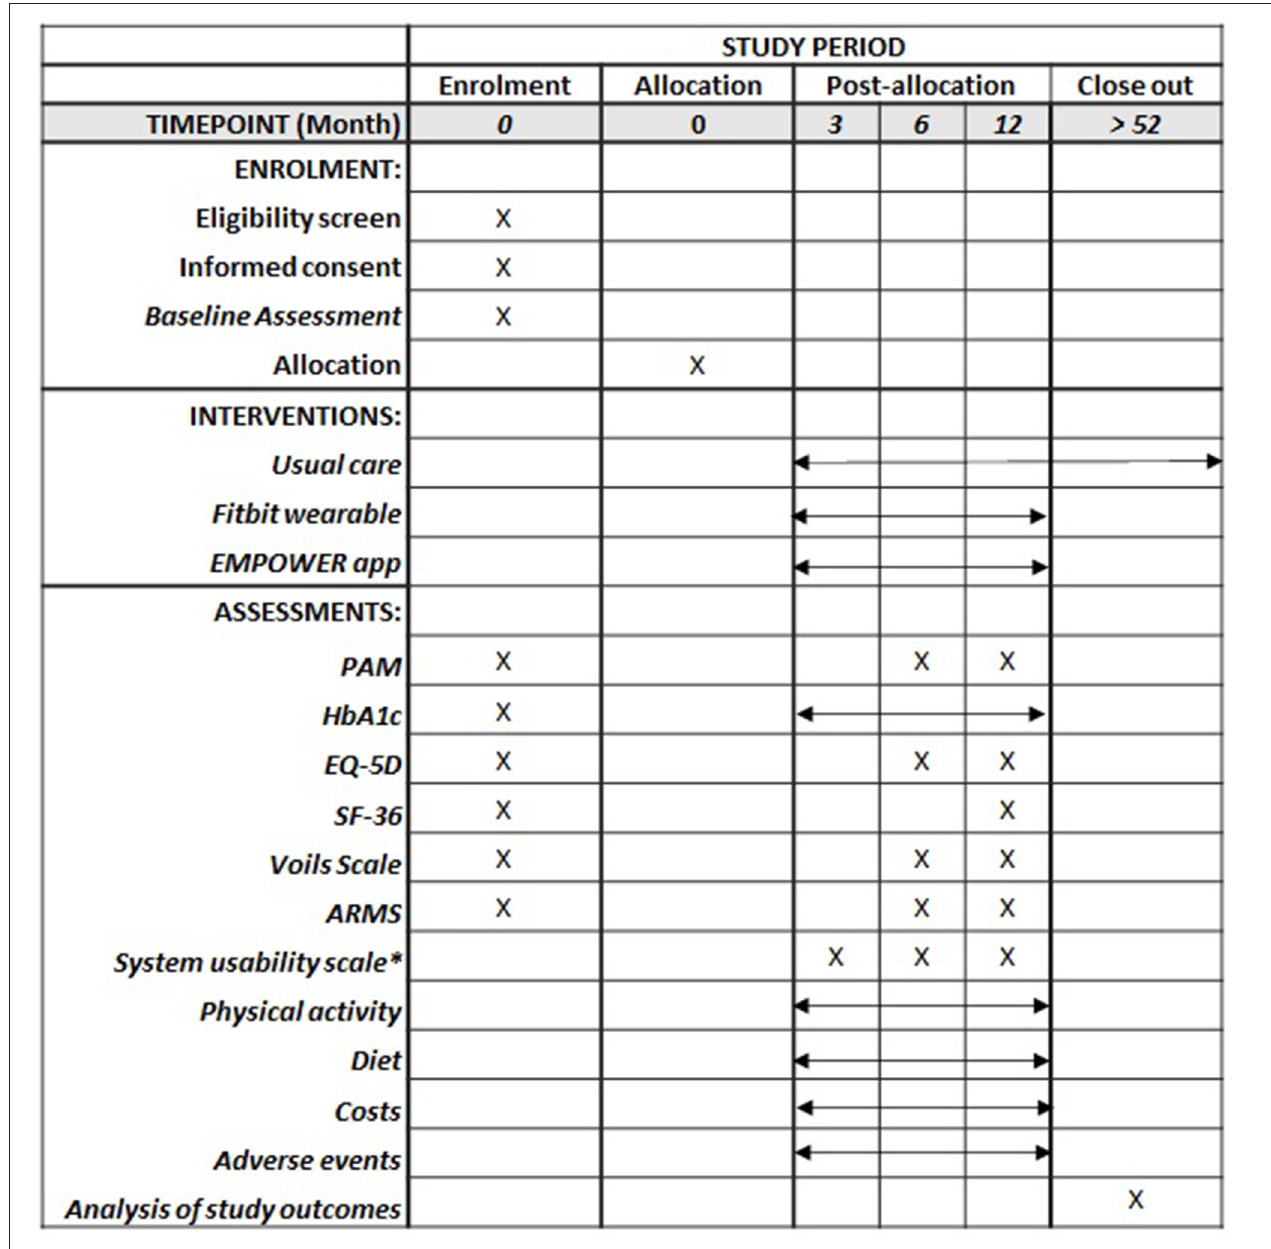
FIGURE 1 | SPIRIT figure for the schedule of enrolment, interventions, and assessments. ARMS, adherence to refills and medication scale; EQ-5D-5L, EuroQoL-5 dimensions; HbA1c, glycated hemoglobin; PAM, patient activation measure; SF36-v2, Short Form-36 Version 2. *Only for participating randomized to intervention